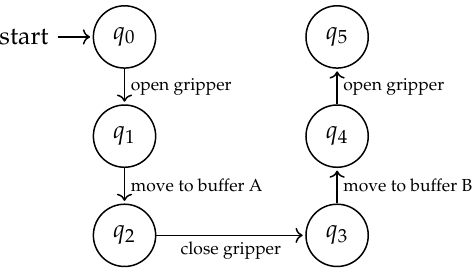
Figure 2. Sequence control for moving a part between two